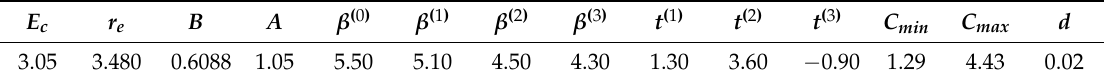
Table 2. Optimized 2NN MEAM potential parameter set for the pure Sn system. The following properties are dimensionful: the cohesive energy E c (eV/atom), the equilibrium nearest-neighbor distance r e (Å), and the bulk modulus B (10 12 dyne/cm 2 ). The reference structure is fcc